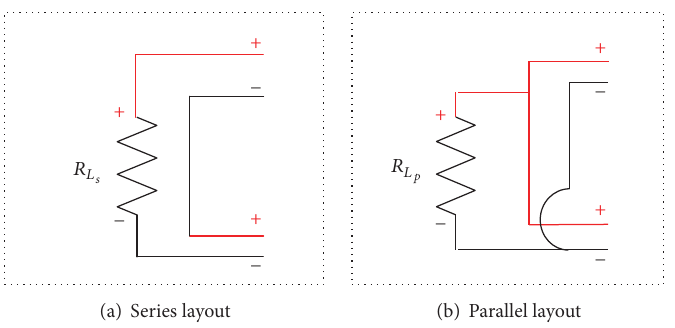
Figure 12: 1 × 2 rectenna arrays.